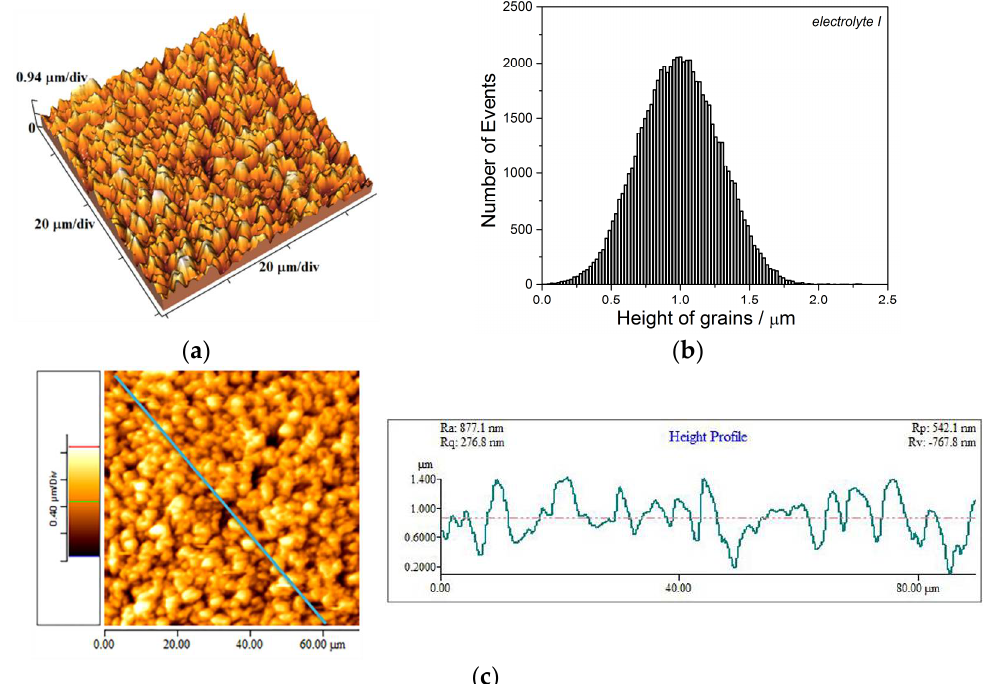
Figure 5. The AFM analysis of 20 µm thick Cu coating obtained by electrodeposition at a current density of 50 mA cm -2 on the Si(111) substrate from electrolyte I : ( a ) the surface topography, ( b ) the histogram and ( c ) line section analysis (X-axis: distance line; Y-axis: height profile). Scan size: (70 × 70) µm 2 .